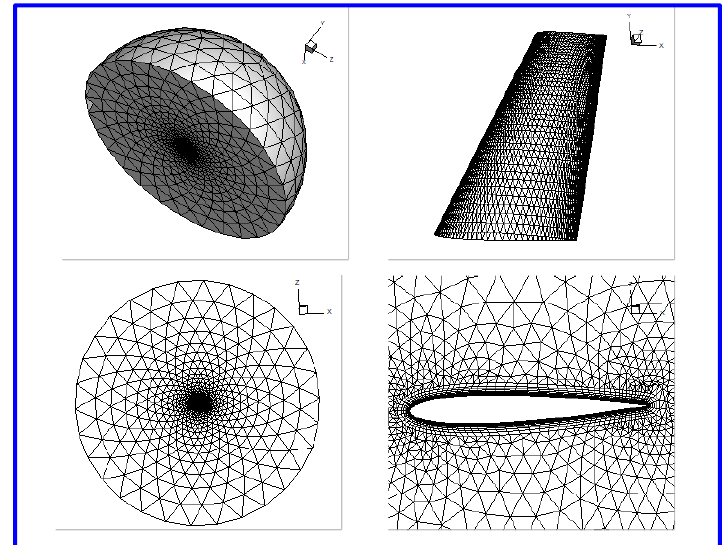
Figure 9. Computational grid of 3-D wing.